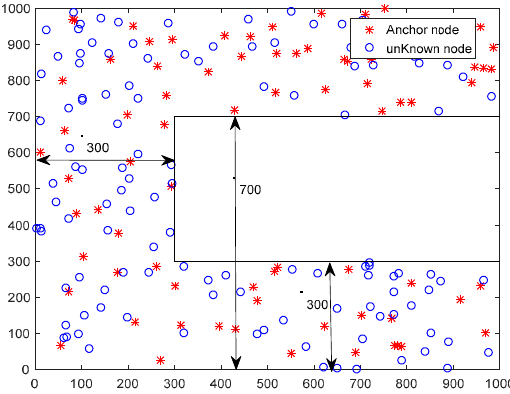
Figure 3. Illustration of deployment for WSN#1 .